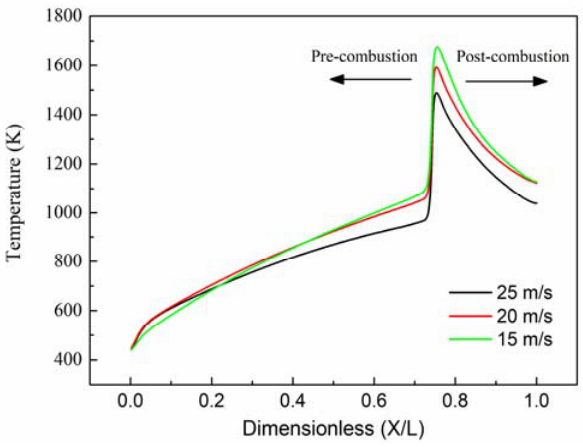
Figure 3. Profiles of wall temperature along the axis on combustion side. t = 10 s, C ch4 , in = 2%.